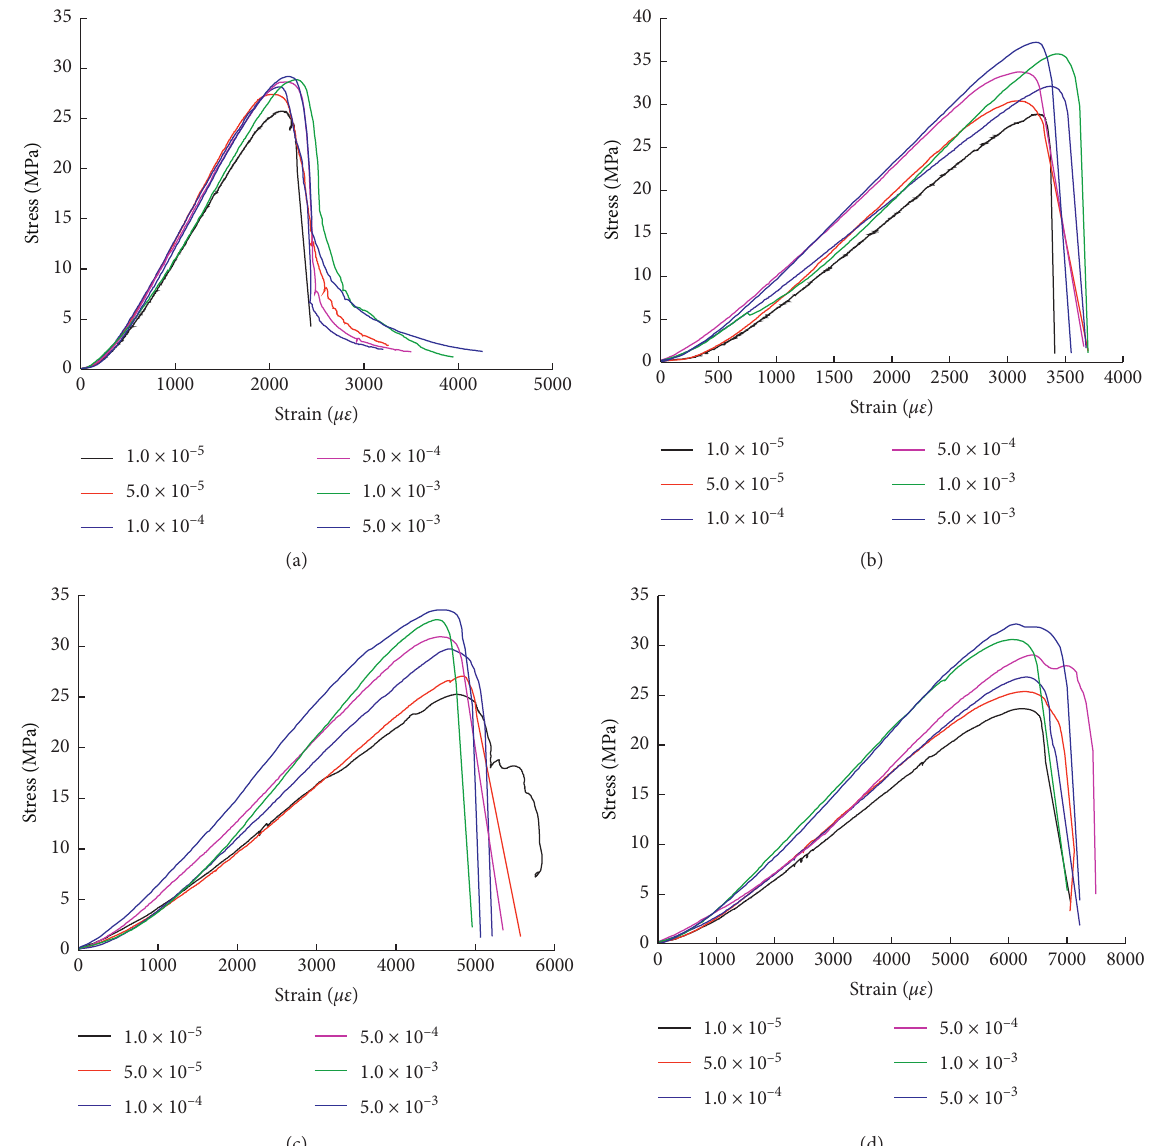
Figure 4: Compressive stress-strain curves of polypropylene fiber reinforced concrete under different loading conditions. (a) 0%. (b) 0.2%. (c) 0.4%. (d)